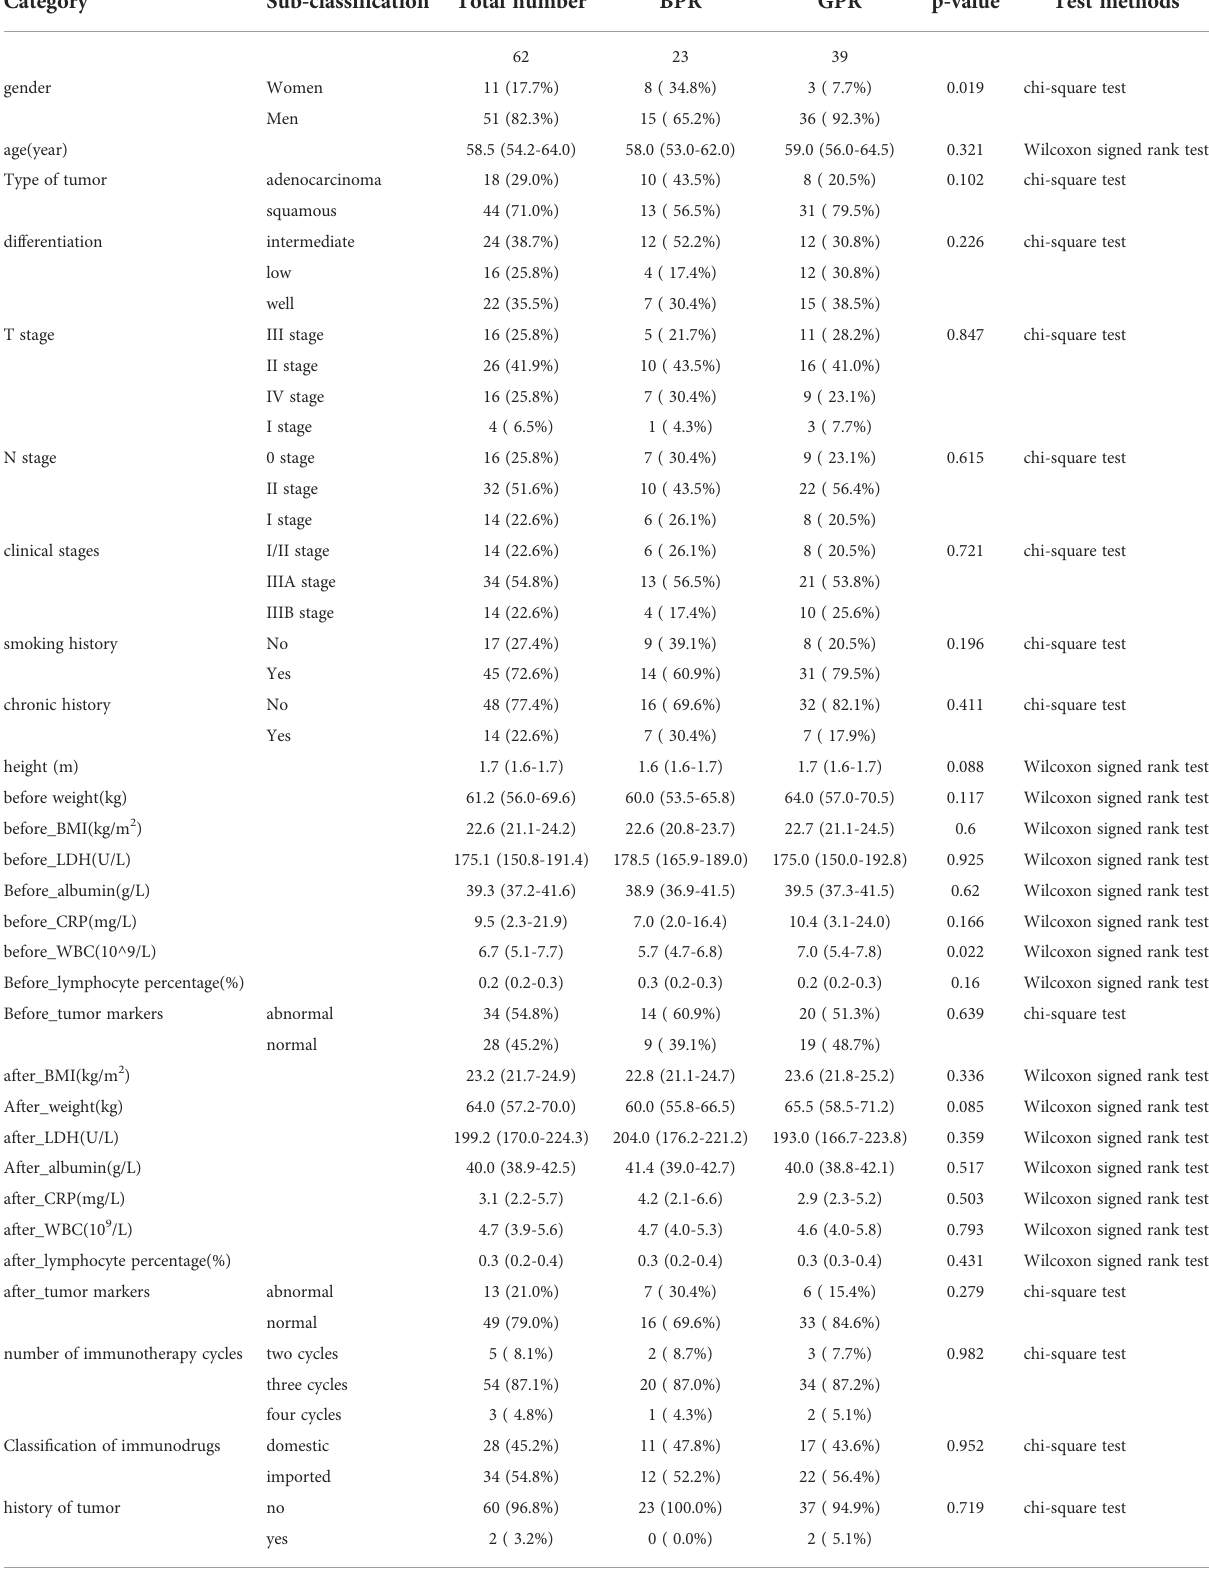
TABLE 4 General information of clinicopathological